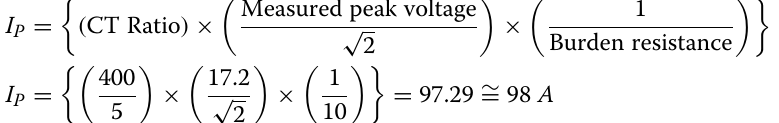
transformer is 400/5, the burden resistance used is 10 W, 10 Ω power resistor. The peak voltage measured is 17.2 V. The primary current calculated as: Measured peak voltage ( CT Ratio ) I P √ 2 = (cid:31) × (cid:30)